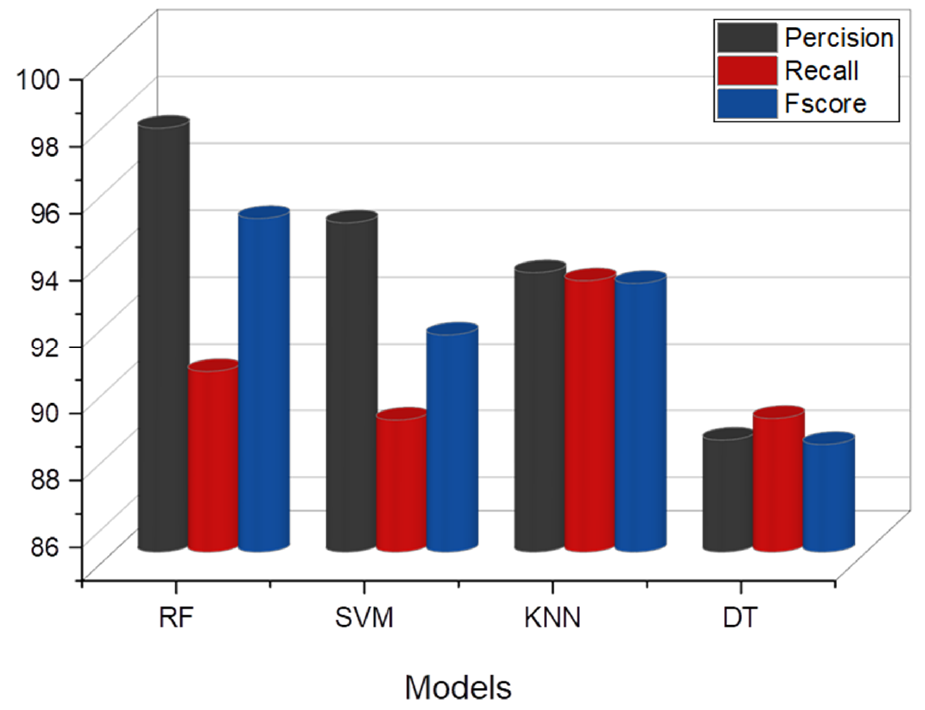
Figure 10. Average precision, recalls, and fscores of 10-fold cross validation over training data and their standard deviation for the four developed models.